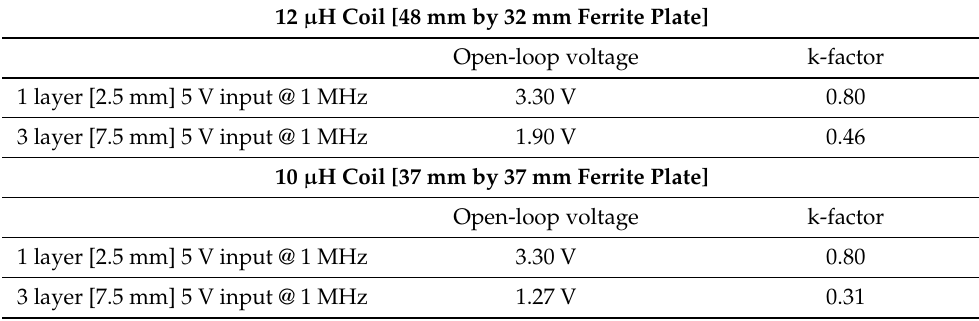
Table 1. Open-loop voltage test to estimate the coupling factor.